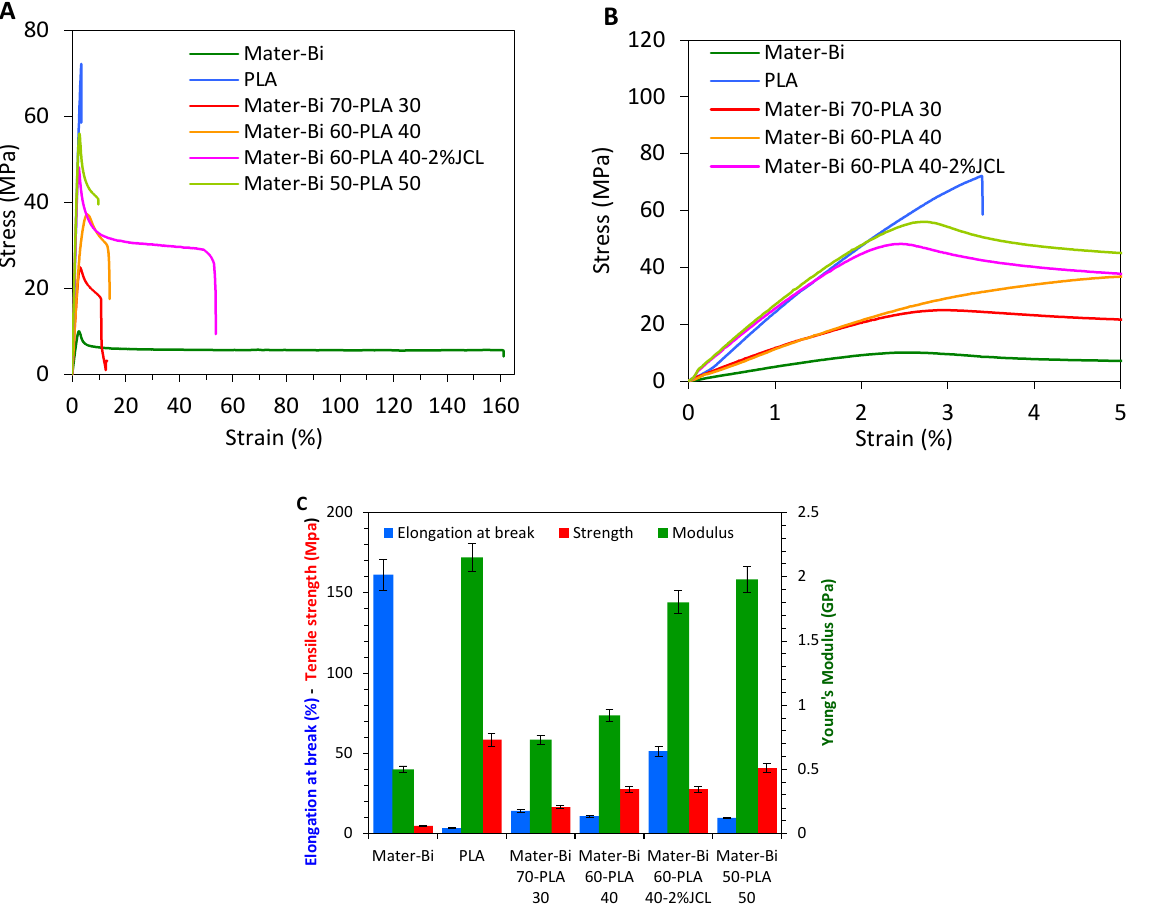
Figure 1. ( A , B ) Tensile stress–strain curves of different compositions of Mater-Bi ® /PLLA blends; Figure 1. ( A,B ) Tensile stress–strain curves of different compositions of Mater ‐ Bi ® /PLLA blends; ( C ) ( C ) tensile strength, Young’s modulus, and elongation at break for Mater-Bi ® /PLLA tensile strength, Young’s modulus, and elongation at break for Mater ‐ Bi ® /PLLA blends.